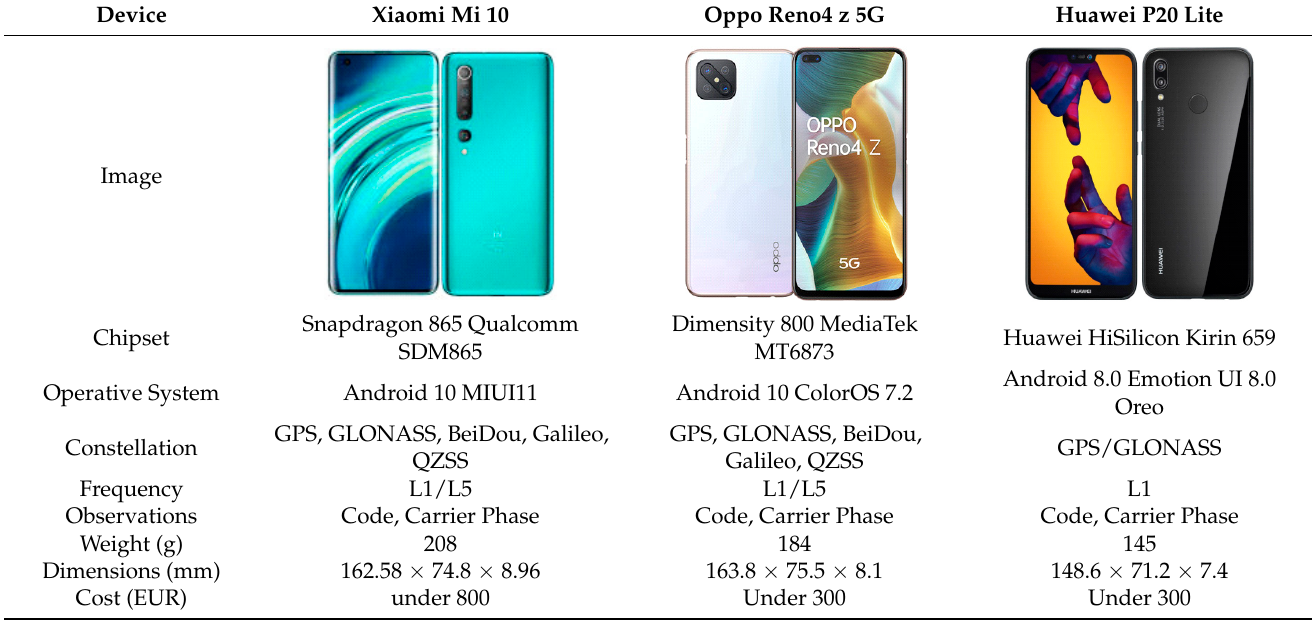
Table 1. Main features of the smartphones used in the experimentation.